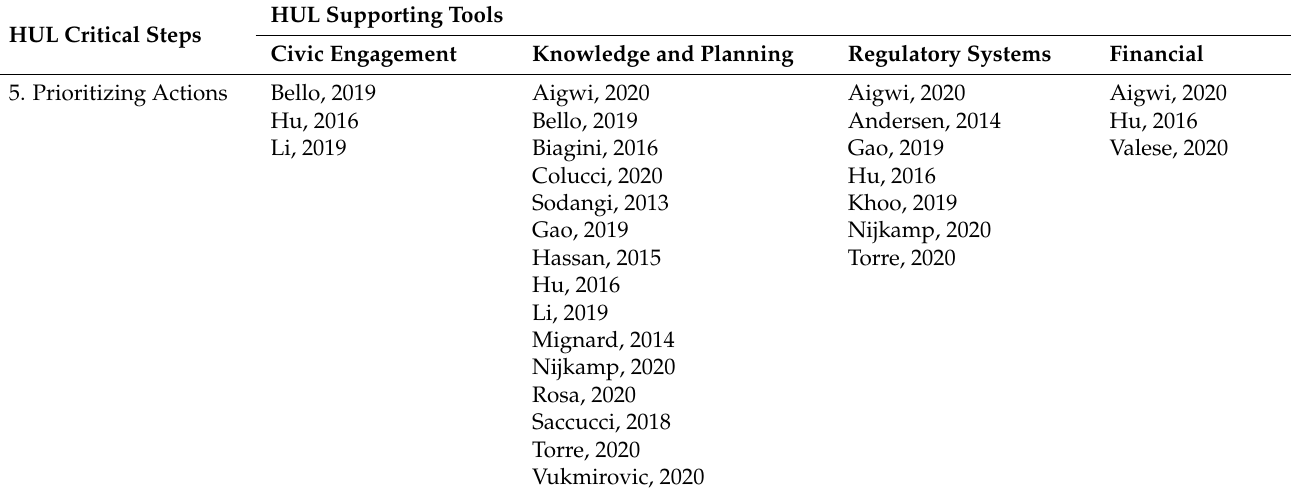
Table 5. List of authors discussing the prioritizing actions supporting tools of the HUL approach within the urban heritage facility management field.